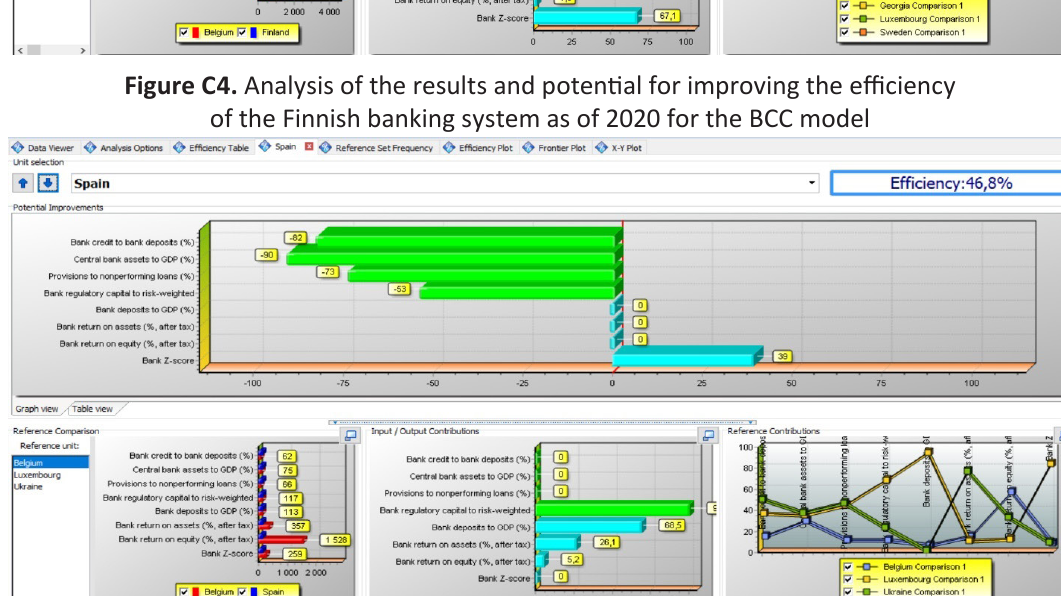
Figure C5. Analysis of the results and potential for improving the efficiency of the Spanish banking system as of 2020 for the BCC model